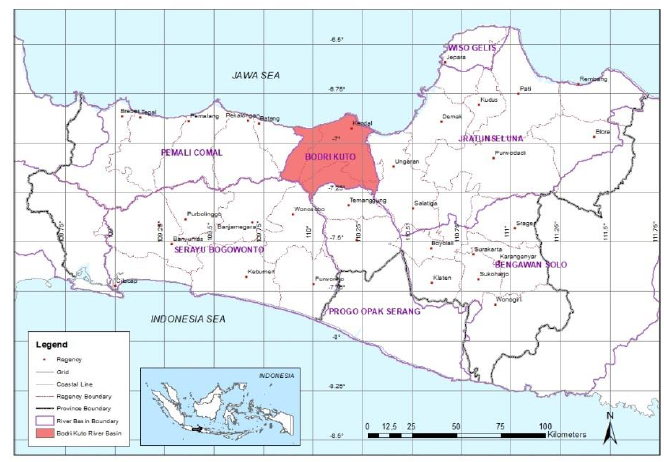
Figure 1. Location of the study area in the Central Java province.